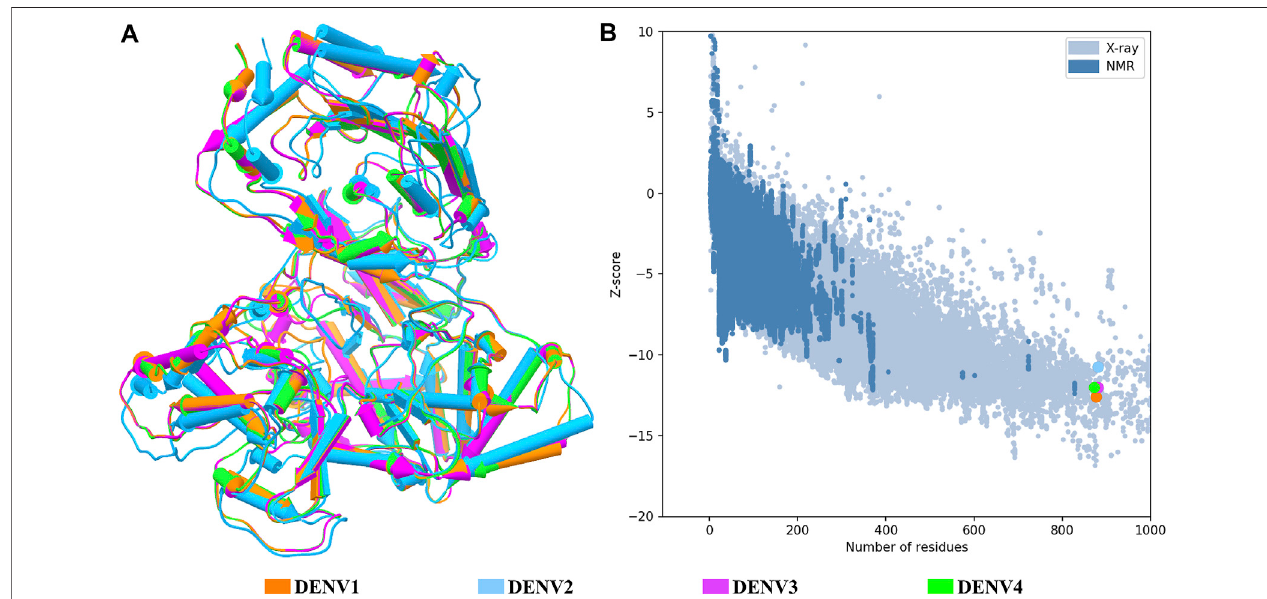
FIGURE1| Structuralquality ofthe NS5 models ofDENV. (A) Superpositionofthefour structuresoftheDENVNS5 protein. The3D structure isshown in pipes for alpha-helix and planks for the beta-sheet. (B) Graphic generated by the ProSA web server; each model showed a Z-score value as follows: DENV1 of – 12.6, DENV2 of – 10.68, DENV3 of – 12.09, and DENV4 of – 11.94. The dots in B follow the same color code as shown in